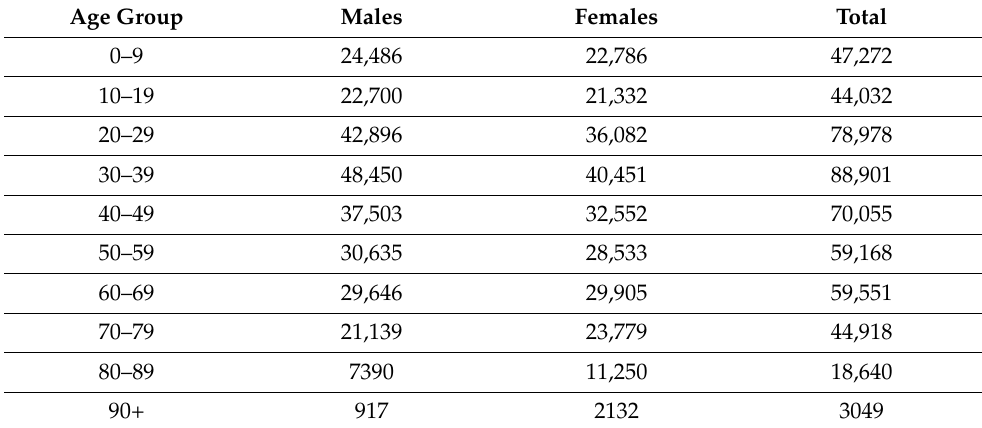
Table 1. Population of the Maltese Islands by age group and sex as at 31 December 2019